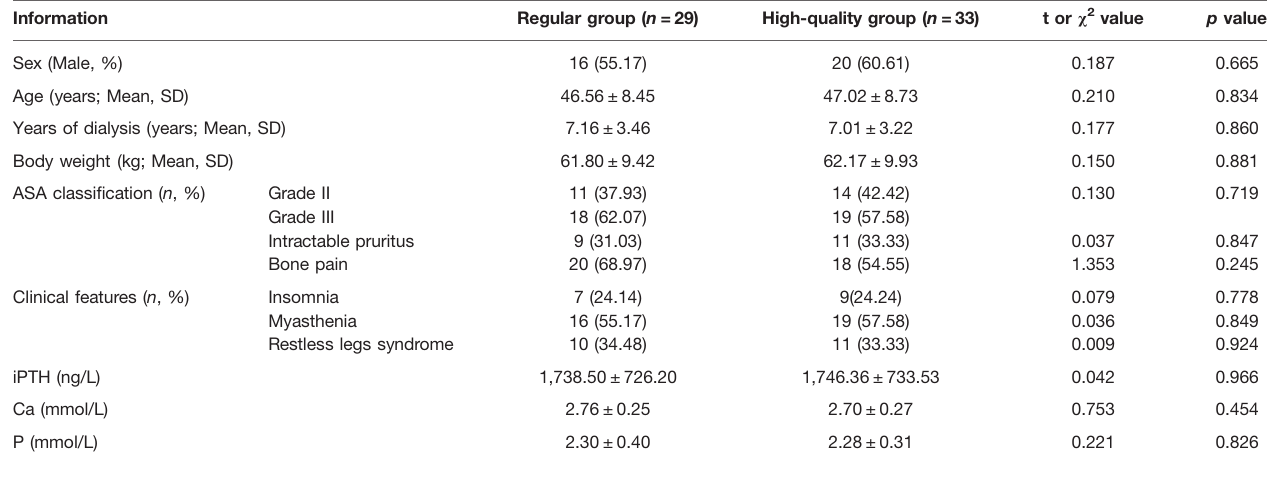
TABLE 1 | General condition level clinical characteristics of patients before care.